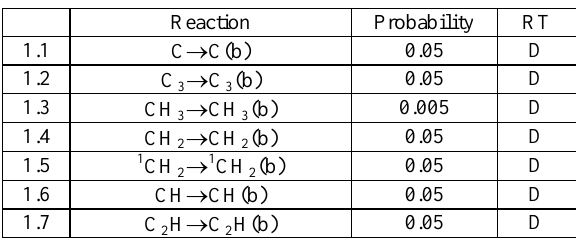
Table 3. Probabilities of the surface reactions on the wafer, model